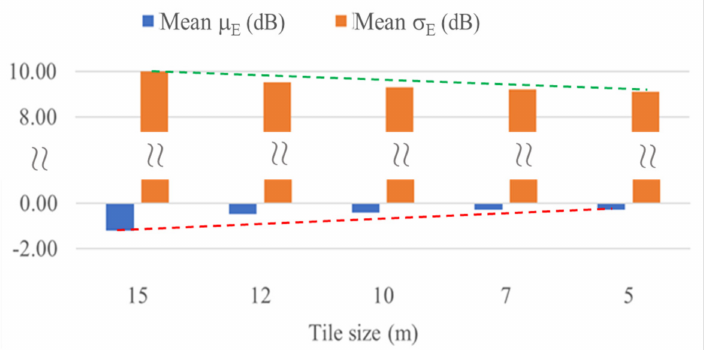
Figure 4. Performance of the DED-RL in the San Francisco scenario (mean error and mean standard deviation of error w.r.t. measurements) for different tile